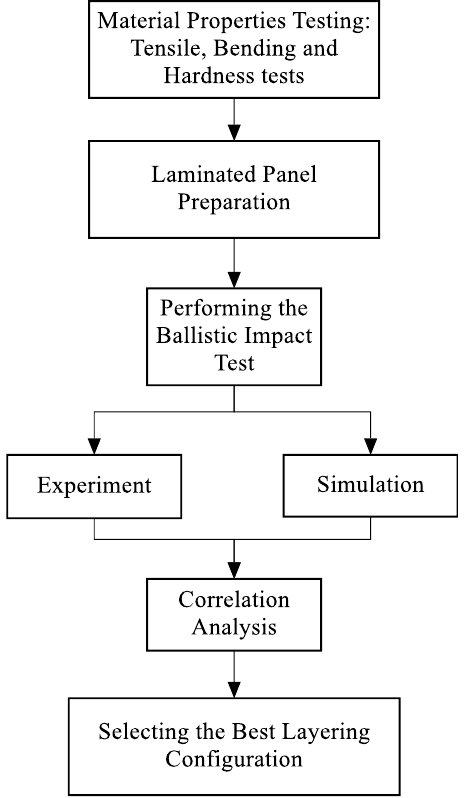
Figure 1 . Flow diagram of a methodology used for this work. Figure 1. Flow diagram of a methodology used for this